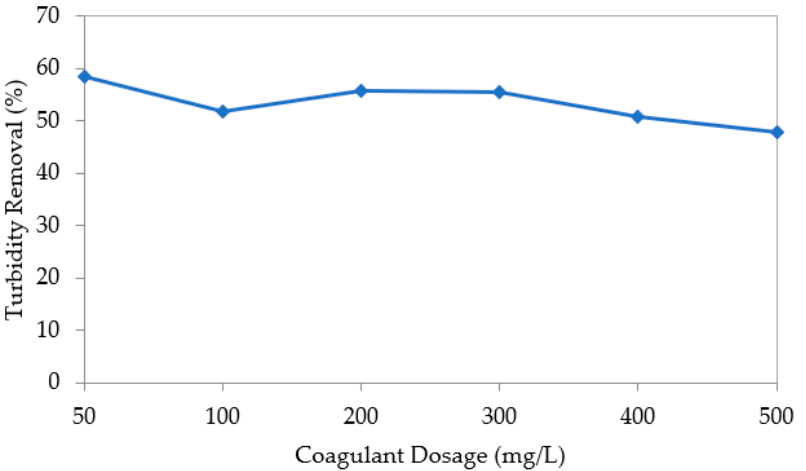
Figure 6. Turbidity removal using extracted bagasse as a natural coagulant with different coagulant dosages at a constant of pH 6.